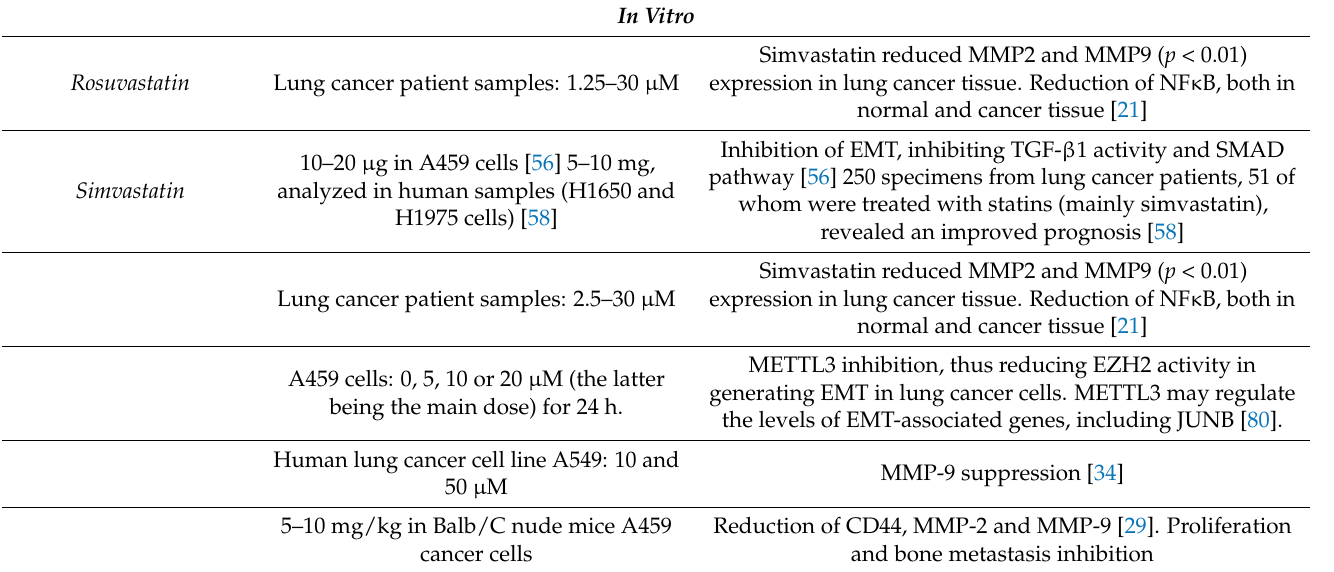
Table 5. Statins’ effects on chemotaxis, invasion and angiogenesis in lung cancer. In Vitro Rosuvastatin Lung cancer patient samples: 1.25–30 µ